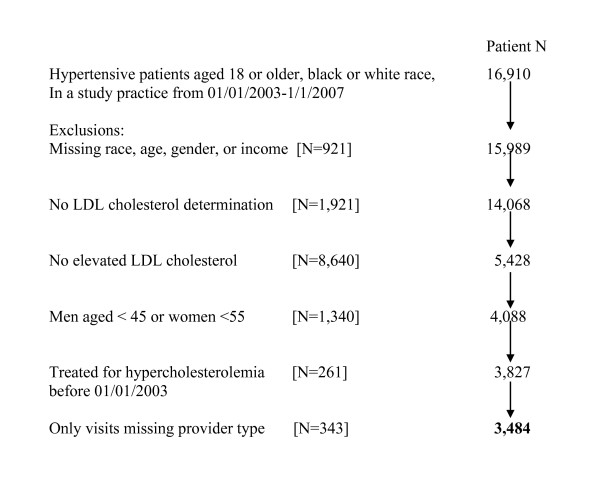
Derivation of Study Cohort of Older Hypertensive Patients with Dyslipidemia.